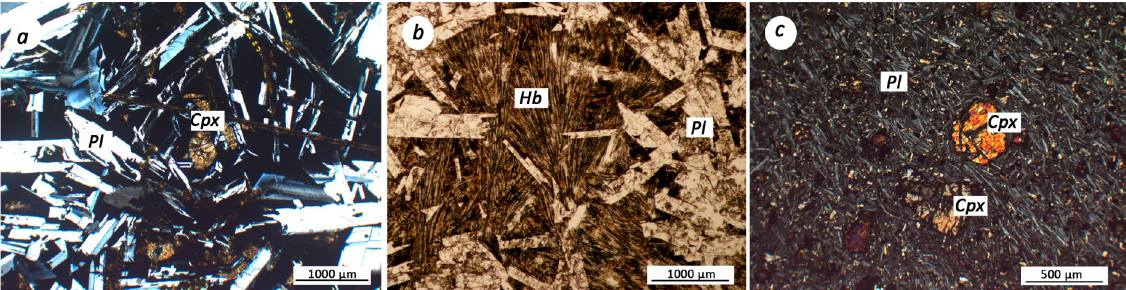
Fig. 3. Photomicrograph (cross-polarizers) showing: (a) clinopyroxene phenocrysts surrounded by plagioclase laths in basaltic andesite from the Bayantsagaan volcanic field (sample BA-01), (b) subhedral acicular Actinolite cryst in the basaltic andesite from the Bayantsagaan volcanic field (sample BA-19), (c) Foliation structure in basalt from Han-Uul volcanic field (UG-03). Abbreviations: Pl – plagioclase; Cpx – clinopyroxene;